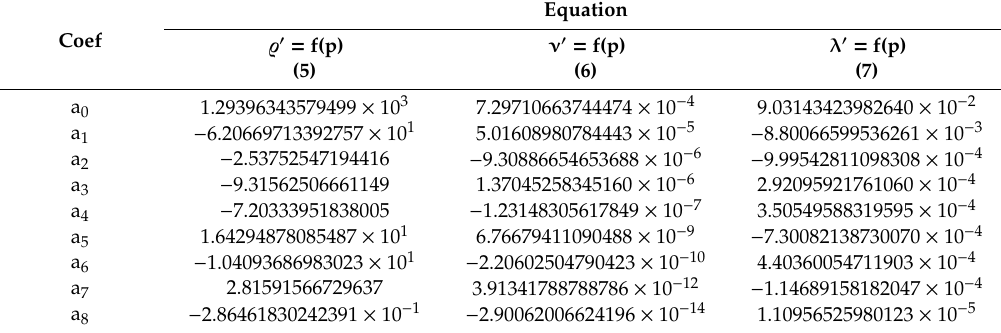
Table 4. Coe ffi cients of polynomials describing the density, specific volume, and heat transfer coe ffi cient of the R1234ze(E) refrigerant in the saturated liquid state.